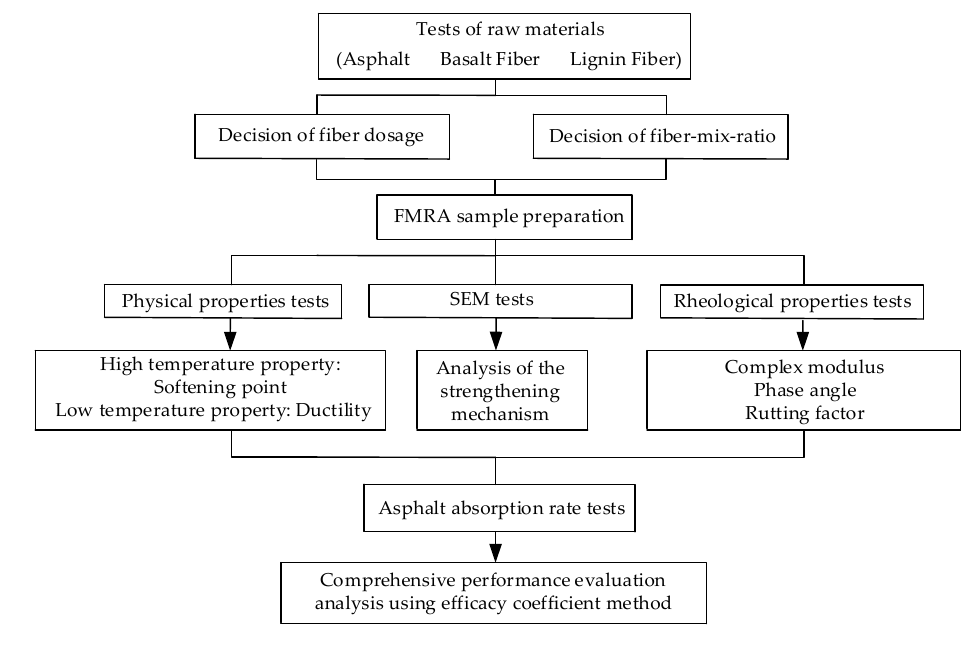
Figure 3. Flowchart of the experiments.